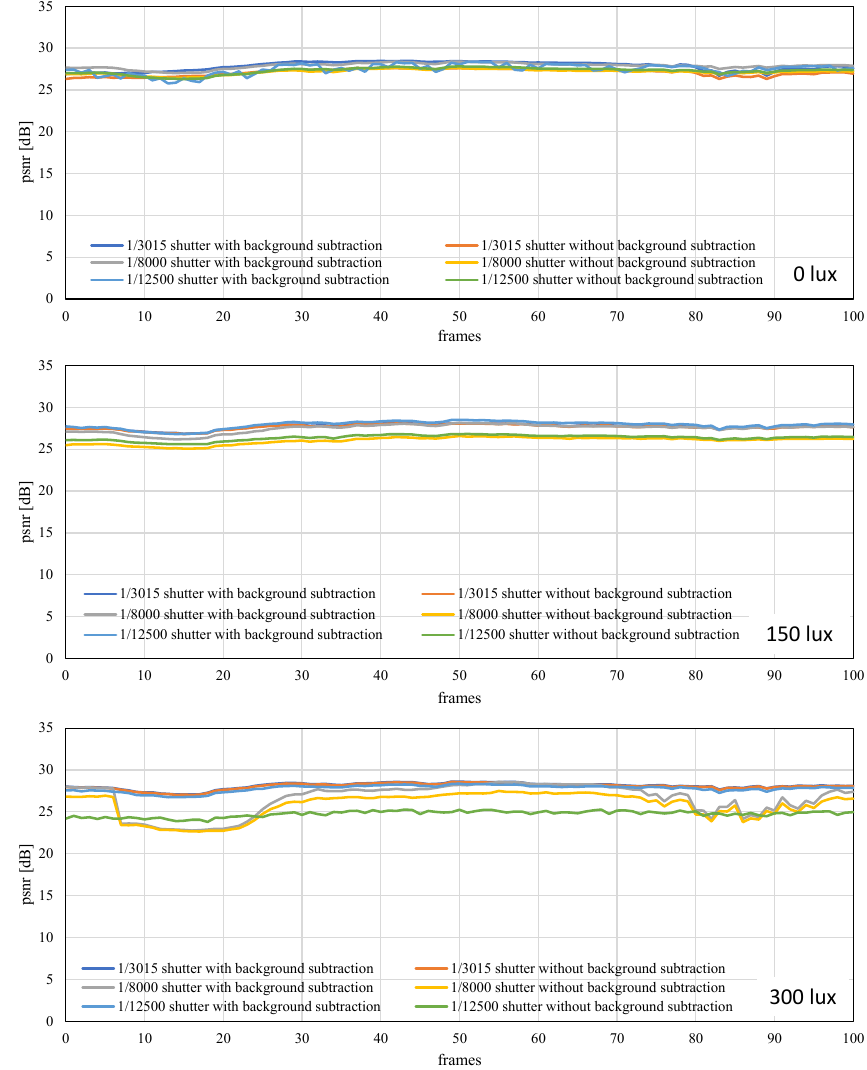
Figure 19. PSNRs when a stored video sequence is streamed with pure binary-code and gray-code images on patterned